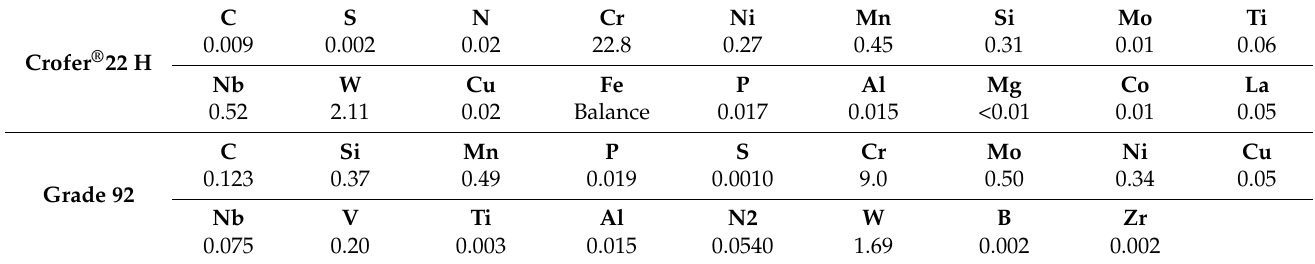
Table 1. Chemical composition of the three Crofer ® 22H sheet materials from one melt and the slab of tempered martensite grade 92 (wt. %).